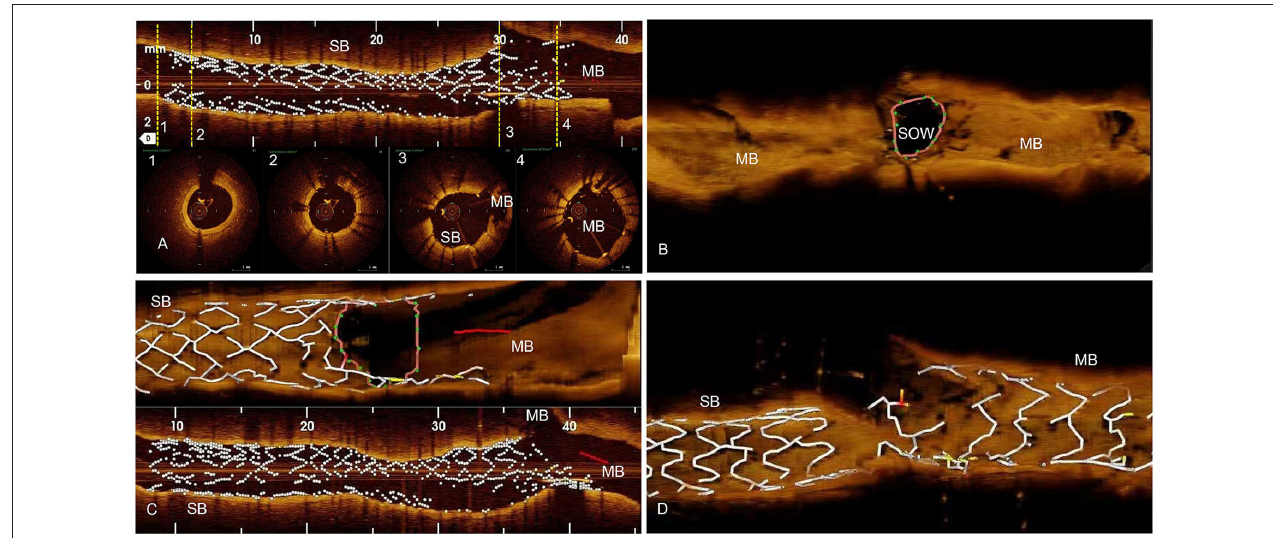
FIGURE 2 | Methods, OCT examinations. (A) The first OCT pullback is done from Side Branch (SB) toward Main Branch (MB), before SB Drug Eluting Stent (DES) is crushed. We analyze distal reference segment (1), distal DES (2), ostial DES (3), and the protruding in MB DES (4) areas. (B) The second OCT pullback is done in the MB after the SB DES is being crushed. Using the 3D reconstruction, we analyze the area of Space of Optimal Wiring (SOW). (C) Third OCT pullback is done from SB to MB after Kissing Balloon one (KBI1) and we analyze for possible SB DES distortions in longitudinal reconstructions, and SB DES ostial area in 3D reconstruction. (D) The fourth OCT pullback after final angiography, from SB to MB, to assess for possible gaps in stent coverage in the polygon of confluence.